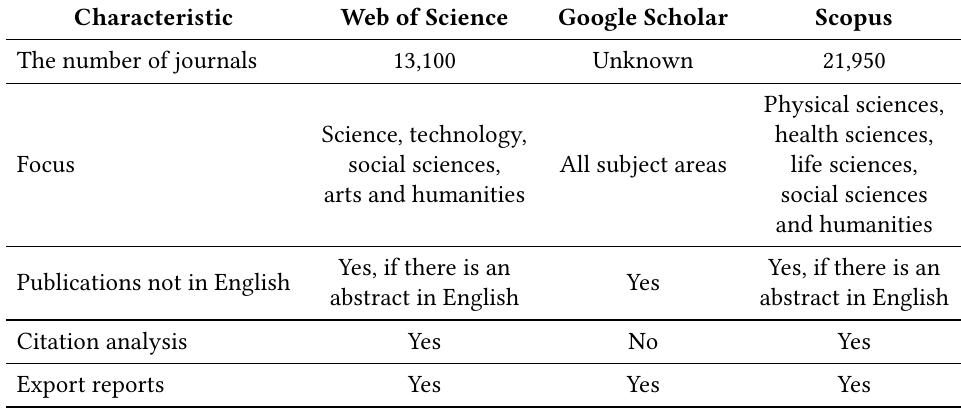
Table 1 Comparative analysis of several scientometric databases (source: https://instr.iastate.libguides.com/c.